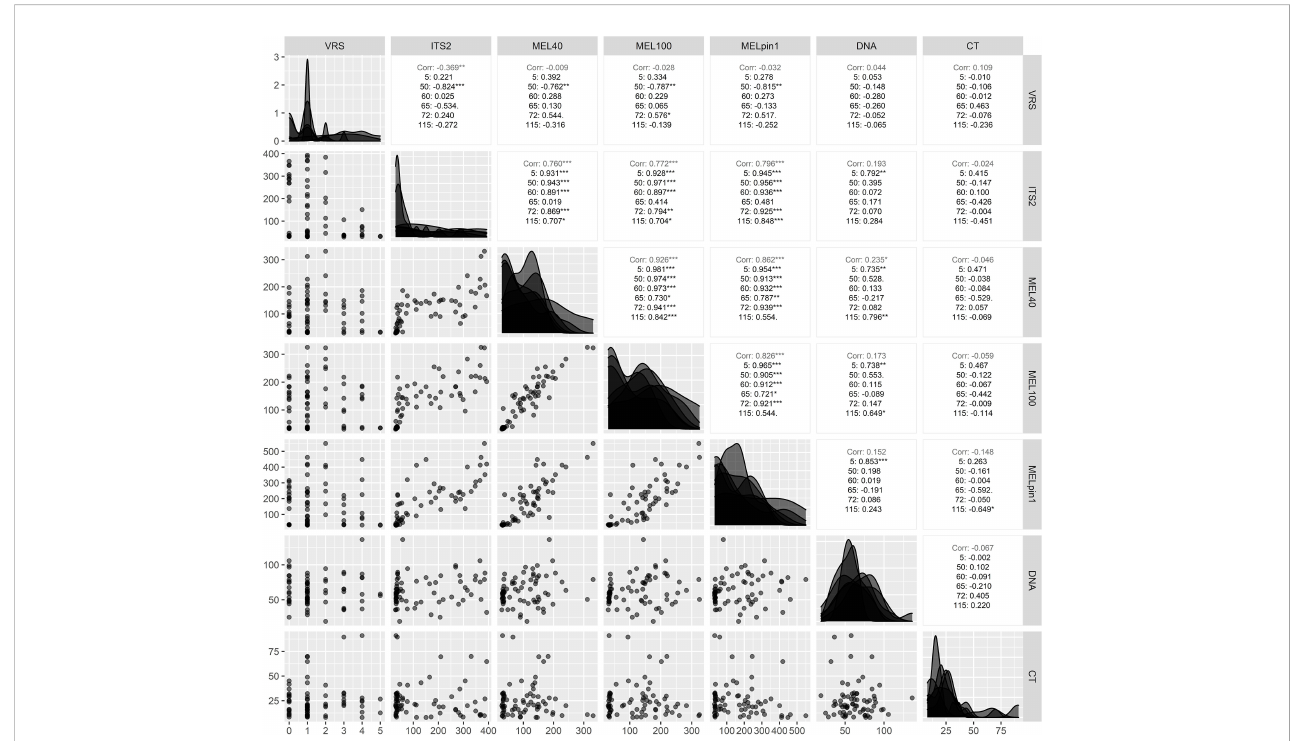
FIGURE 5 Correlations between the VRS scores of leaves from six aspen genotypes and their contents of four molecular markers of fungal abundance: ITS2 (representing the total mycobiome), MEL40 and MEL100 (representing PCR concentration of marker genes for the genus Melampsora ), and MELpin1 (representing PCR concentration of marker gene for the native rust M. pinitorqua ). Data are presented in a diagonalized manner: the left-hand triangle show scatterplots visualizing the pairwise relationships between the responses, while the right-hand triangle show the Pearson correlation coef fi cients between the responses for both the full set of samples and for each genotype individually. The graphs on the diagonal show the distribution of the indicated response within each genotype. *p < 0.05, **p < 0.01, ***p <